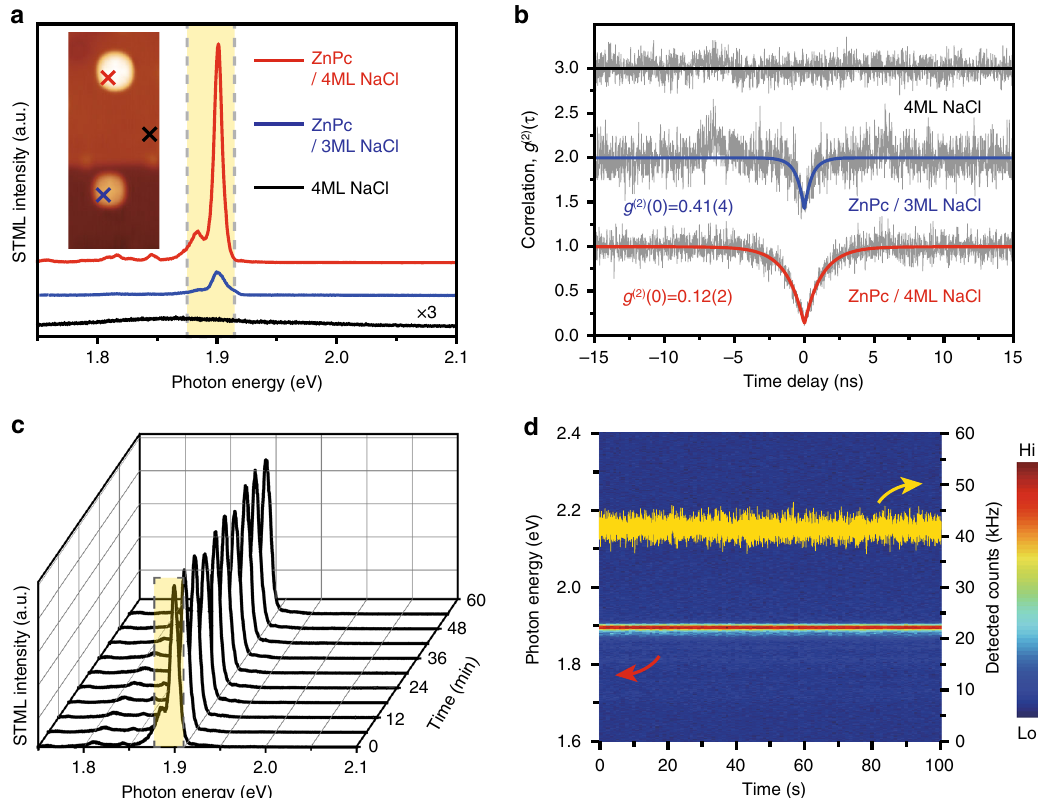
Fig. 4 Electrically driven single-molecule single-photon emission. a STML spectra acquired at different sample sites using the same tip: ZnPc-lobe/4 ML NaCl, ZnPc-lobe/3 ML NaCl, and 4 ML NaCl, respectively ( − 2.5 V, 100 pA, 30 s). The inset of a shows the STM image of isolated ZnPc molecules on 3 and 4 ML NaCl (2.5 V, 2 pA, 16 × 6 nm 2 ). The spectra are offset for clarity. b Second-order correlation measurements of single-molecule electroluminescence at the molecular lobe of a ZnPc ( − 2.5 V, 100 pA) and NaCl ( − 2.5 V, 500 pA), corresponding to the STML spectra in a , respectively. The black , red , and blue lines are the single exponential fi t to the data. The upper curves have been upshifted by multiples of one for clarity. c Consecutive STML spectra acquired every 5 min during second-order correlation measurements at the ZnPc lobe on 4 ML NaCl ( − 2.5 V, 100 pA, 60 s). The yellow areas marked in a , c indicate the detection range of the band-pass fi lters used in the present experiments (1.872 – 1.915 eV). d Short-time trace of STML spectra ( − 2.5 V, 100 pA, 1 s for each spectrum) and intensities (detected by SPAD at a sampling rate of 50 Hz) when the tip is positioned at the ZnPc molecular lobe on 4 ML